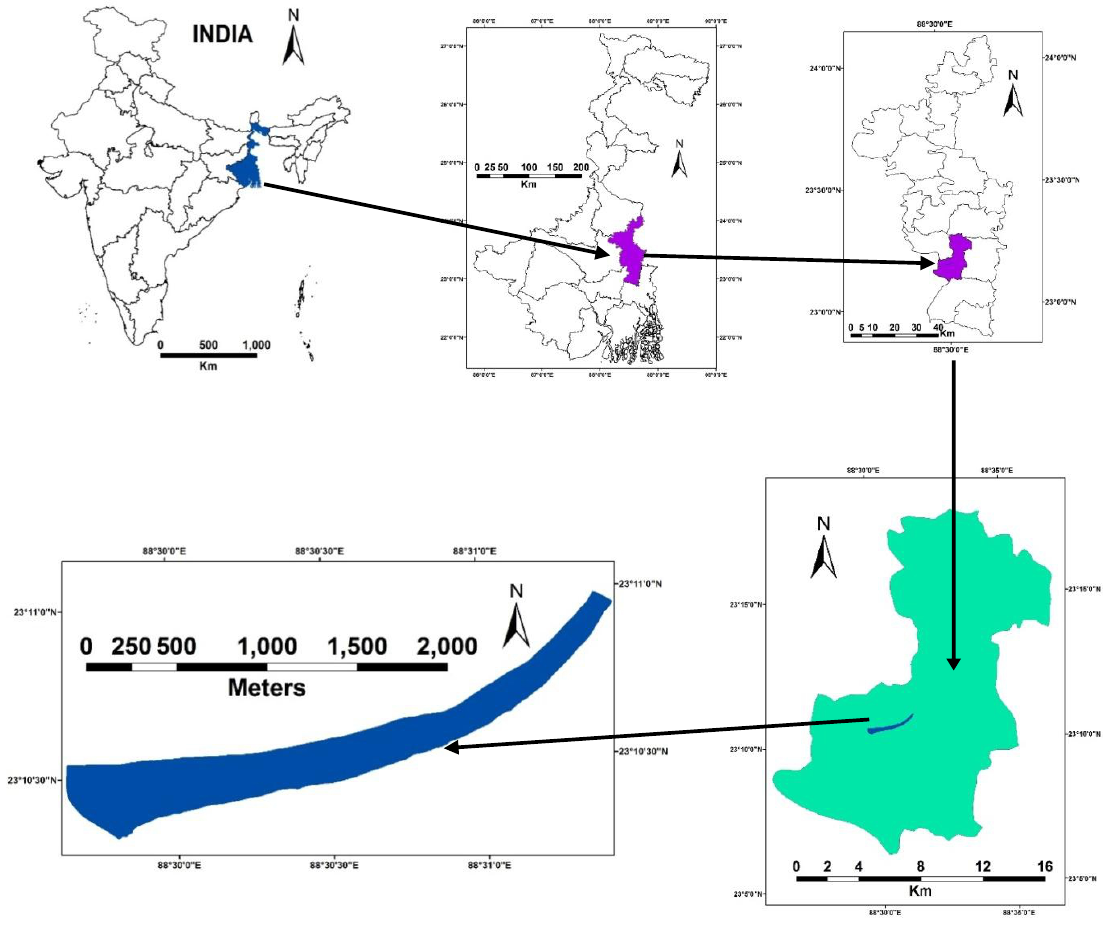
Fig. 1. location map of